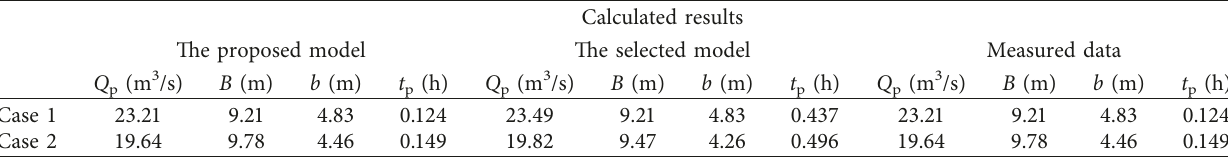
Figure 12: The comparisons of the breach flow hydrographs calculated using two numerical models. (a) Case 1 (b) case 2. Table 4: Comparison of results simulated by two